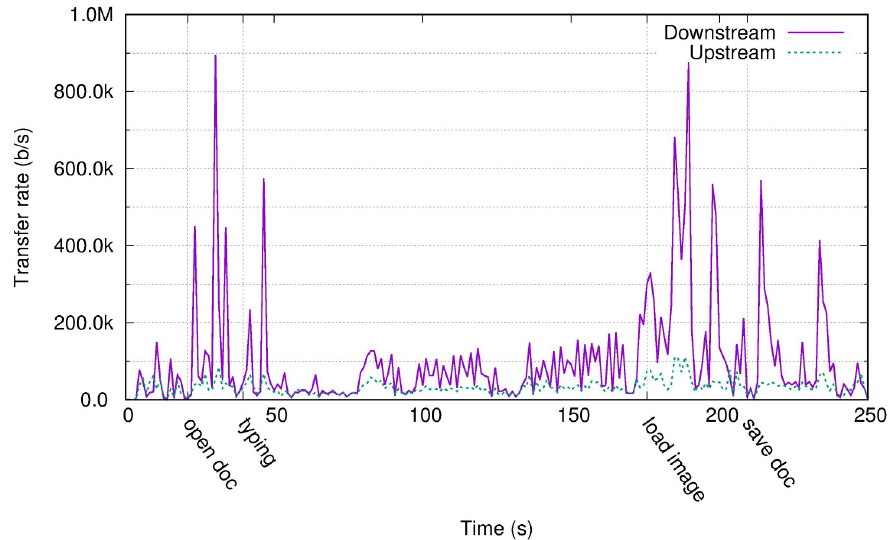
Fig 2. Transfer rate for the office profile in Amazon